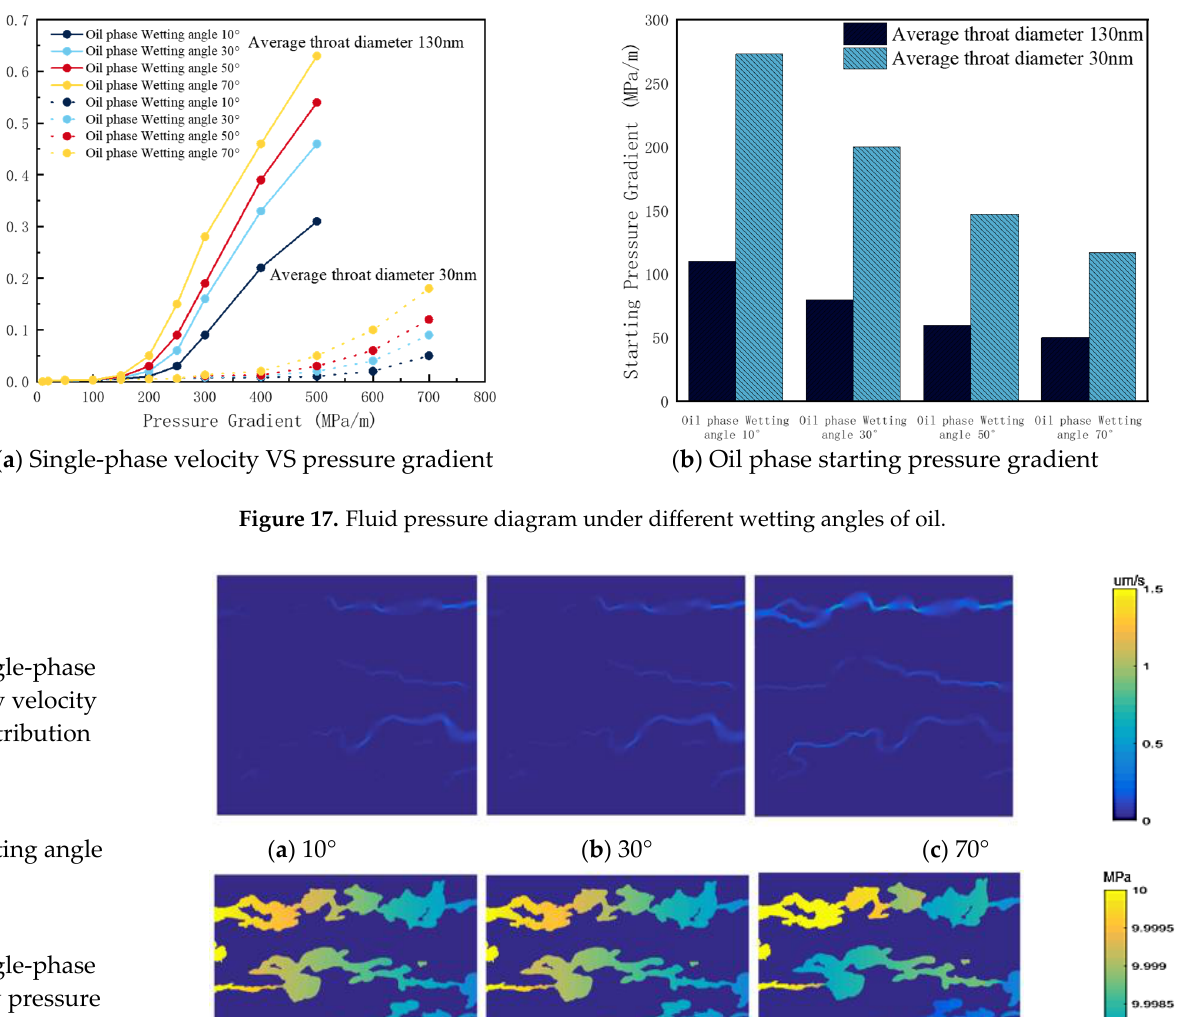
Figure 16. Simulation results of hydrophilic minerals with different proportions. It can be seen from Figure 17 that the starting pressure gradient of single-phase oil flow in the shale matrix decreases with the increase of wetting angle.